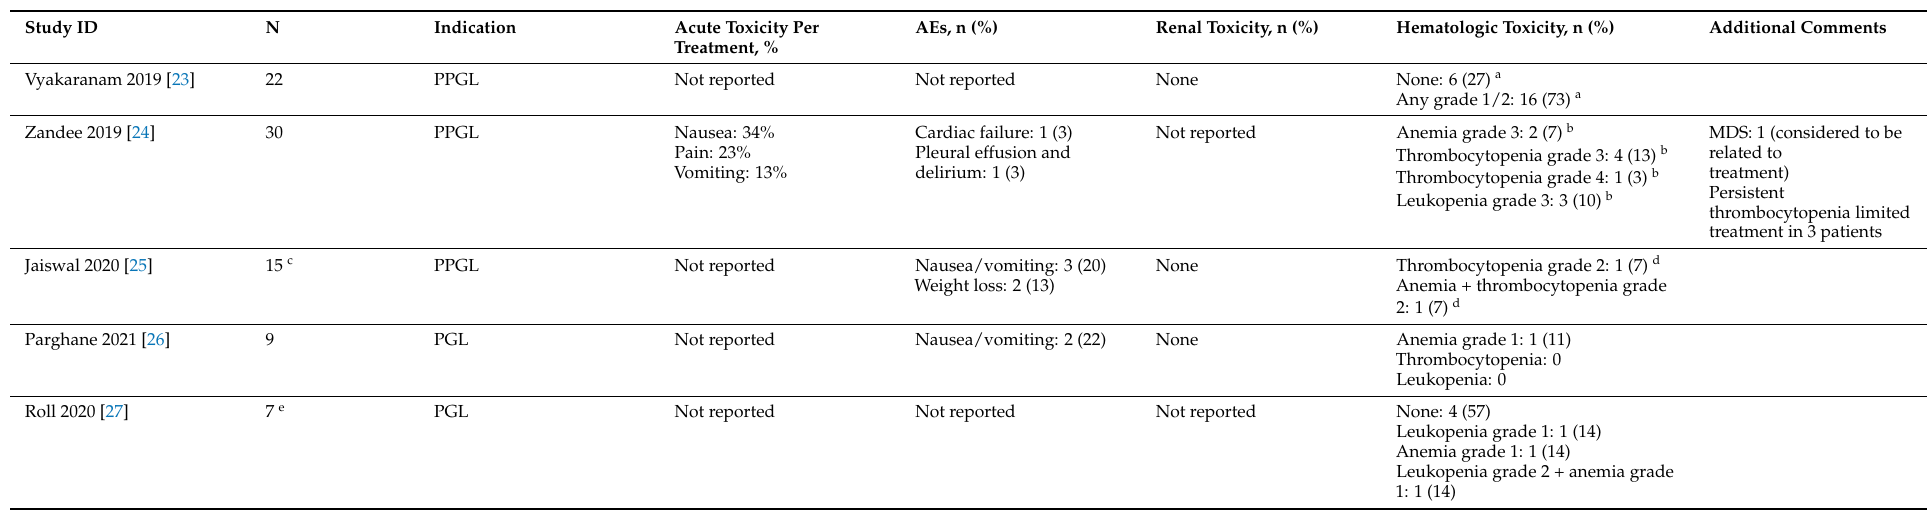
Table 3. [ 177 Lu]Lu-DOTA-TATE safety summary (all